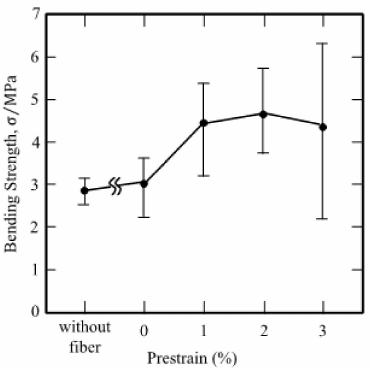
Figure 12. Bending strengths of the plaster prism specimens